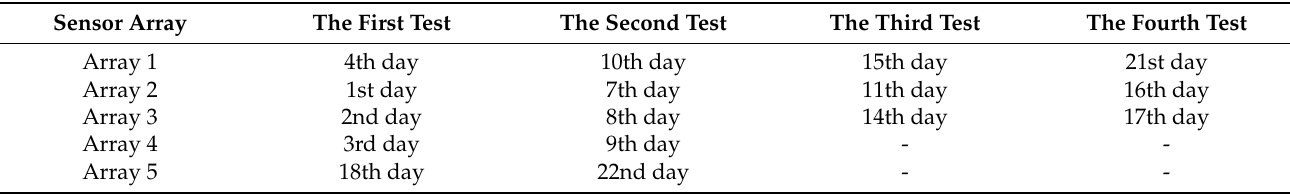
Table 3. The testing schedule for each batch of sensor arrays.